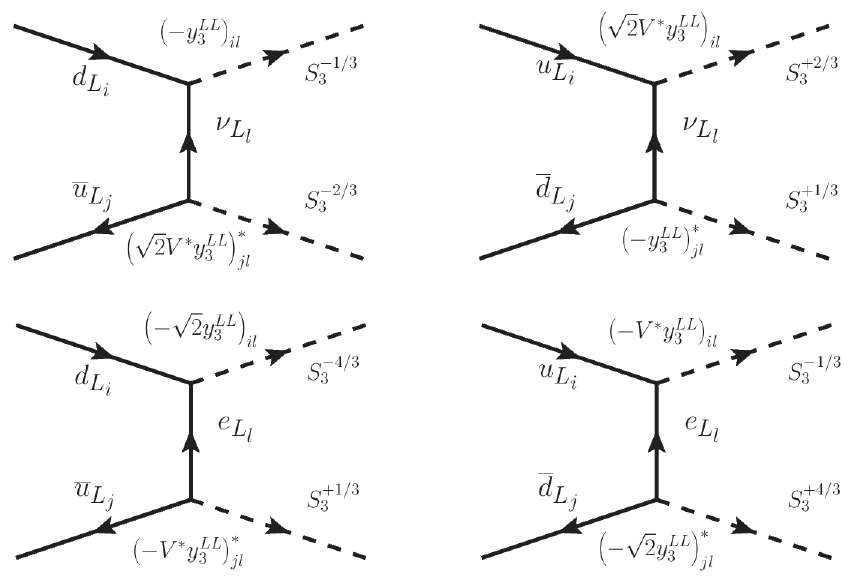
Figure 8 . Asymmetric pair production for the case of S 3